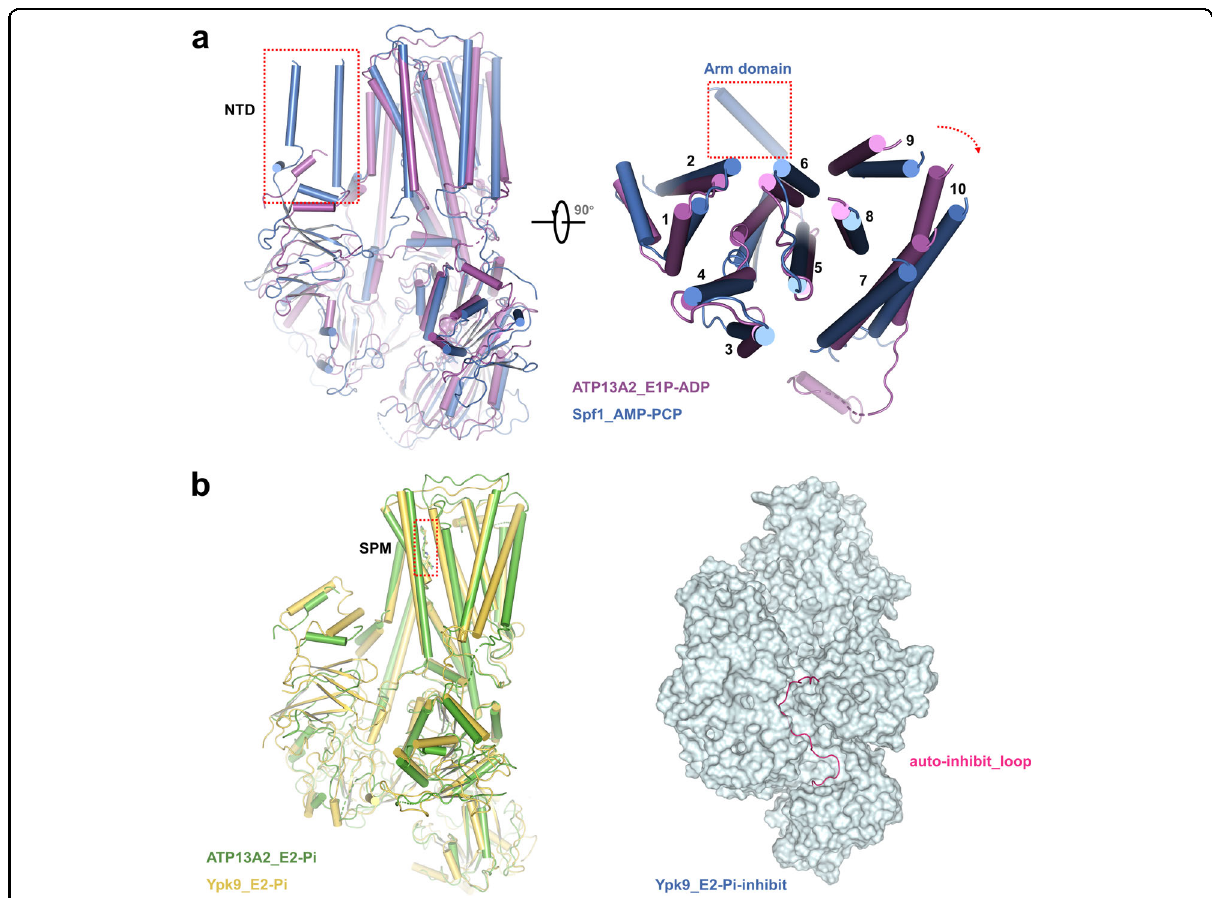
Fig. 4 Structural comparisons of ATP13A2 with yeast P5A ATPase Spf1 and P5B ATPase Ypk9. a Structural comparison of human ATP13A2 in E1P-ADP state (purple) and Spf1 in E1-AMPPCP state (blue). The N-terminal Arm domain of Spf1 is shown in the red dashed box. b Structural comparison of human ATP13A2 in E2-Pi state (green) and Ypk9 in E2-Pi state (yellow) (left). Surface representation of the Ypk9 in E2-Pi-inhibit state, the auto-inhibit loop is colored magenta